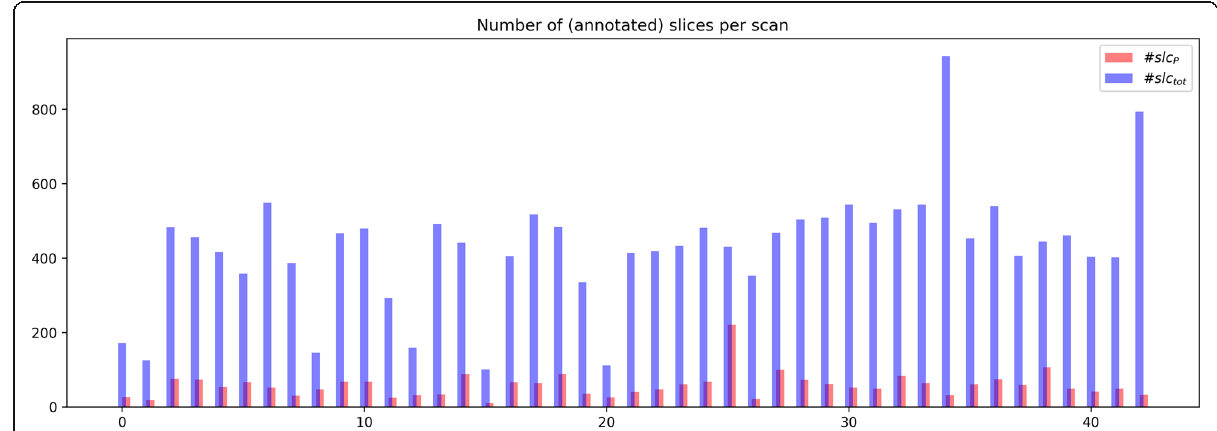
Fig. 2 Distribution of the annotated data. Blue bars (#slc tot ) show the total number of slices for each scan, and red bars (#slc p ) show the annotated number of slices for each